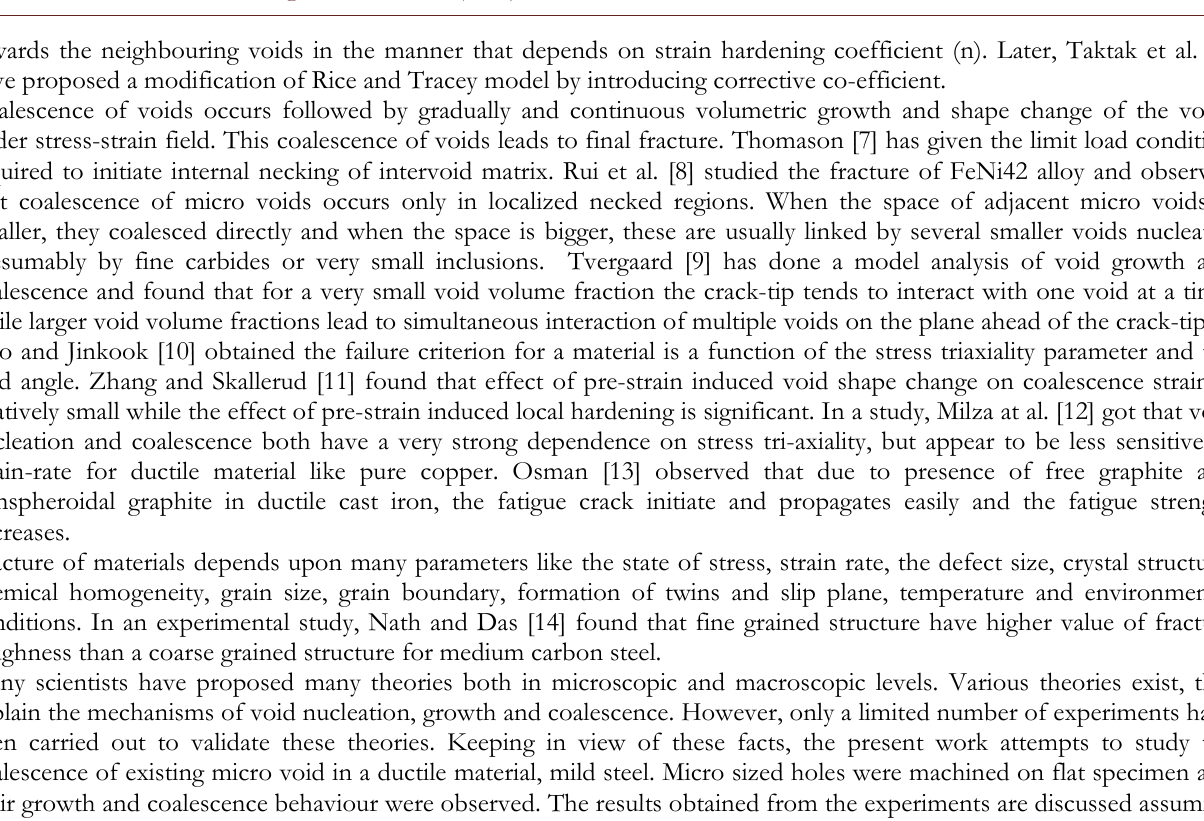
E XPERIMENTATION Plan of